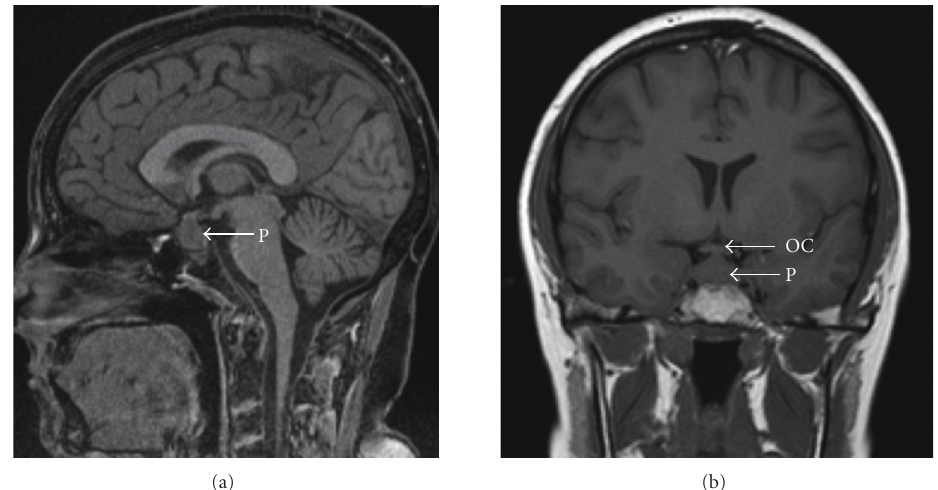
Figure 1: (a) Sagital volumetric interpolated breath hold examination (VIBE) image demonstrating enlarged pituitary with loss of T1W increased signal in the posterior pituitary lobe consistent with diabetes insipidus. (b) Coronal T1W image demonstrating the enlarged pituitary in relation to the optic chiasm. OC : optic chiasm and P : pituitary.